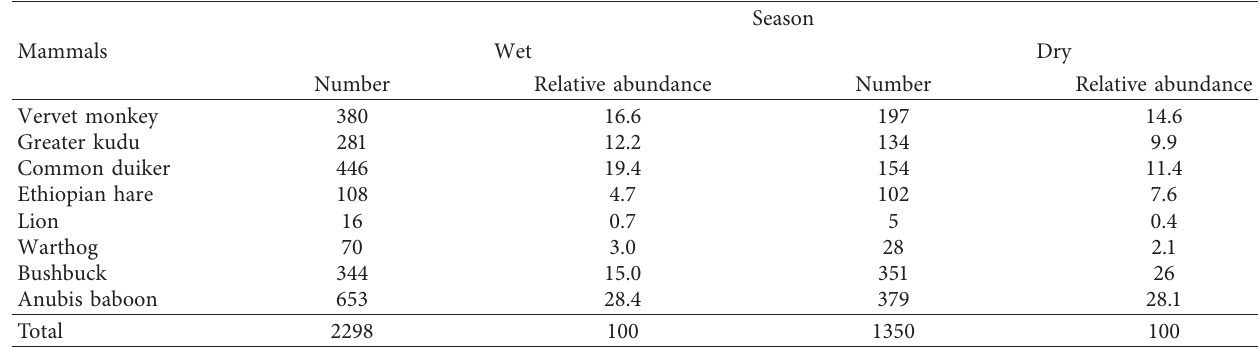
Table 4: The relative abundance of mammals during wet and dry seasons.